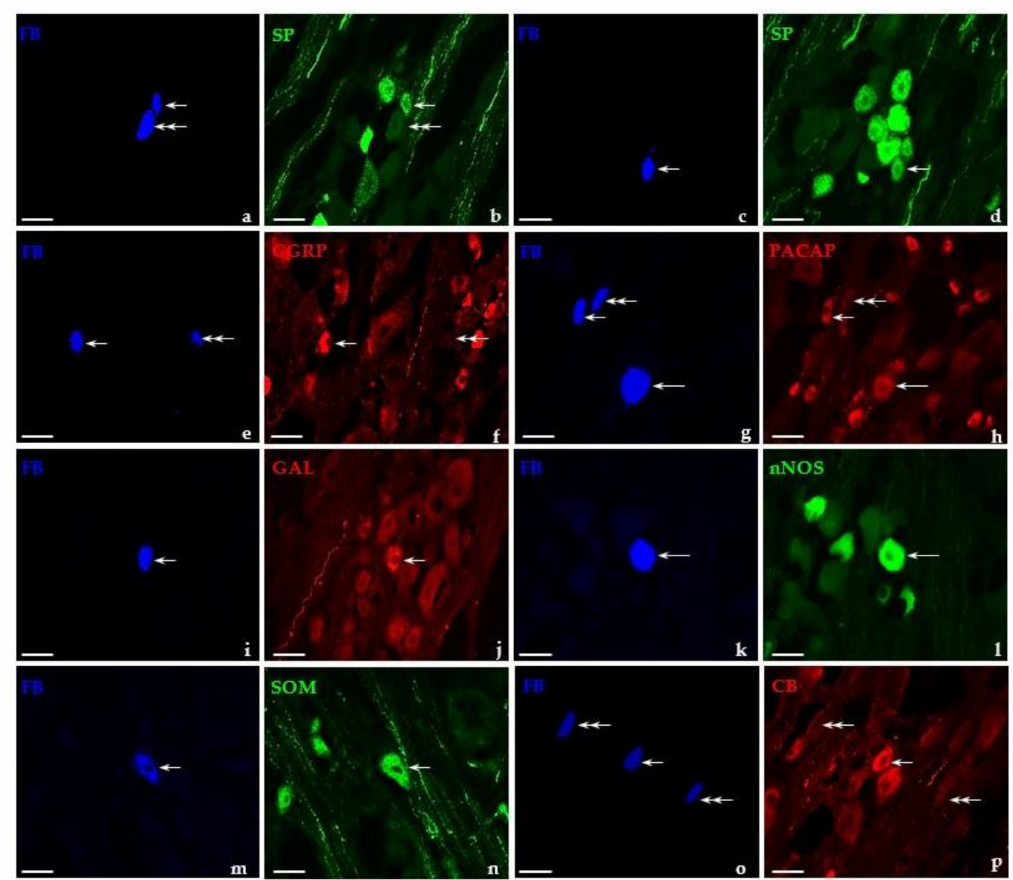
Figure 5. Representative images of DRG-UB-PNs in the GUA-treated pigs. All the images were taken separately from blue ( a,c,e,g,i,k,m,o ), green ( b,d,l,n ), and red ( f,h,j,p ) fluorescent channels. Short arrows represent small-sized FB-positive DRG- UB-PNs ( a,c,e,g,i,m,o ) which were simultaneously SP- ( b,d ), CGRP- ( f ), PACAP- ( h ), GAL- ( j ), SOM- ( n ), or CB-positive ( p ). Long arrows represent middle-sized FB-positive DRG-UB-PNs ( g,k ), which simultaneously contained PACAP ( h ) or nNOS ( l ). Double arrows represent small-sized FB-positive DRG-UB-PNs ( a,e,g,o ), which were simultaneously SP- ( b ), CGRP- ( f ), PACAP- ( h ), or CB-negative ( p ). Bar in all images—50 µ